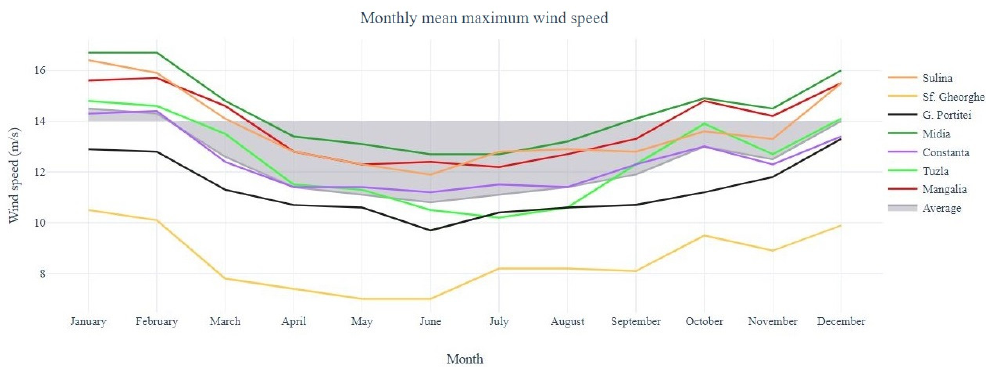
Figure 5. Monthly mean maximum values of the wind speed. Table 3. Monthly mean maximum values of the wind speed.